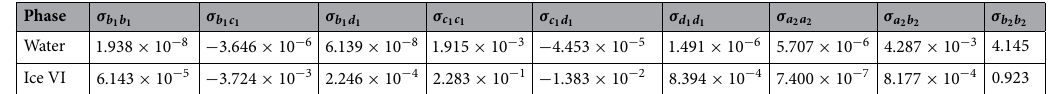
Table 2. Covariance matrix elements for the power-law and Murnaghan-type fittings given in Table 1.